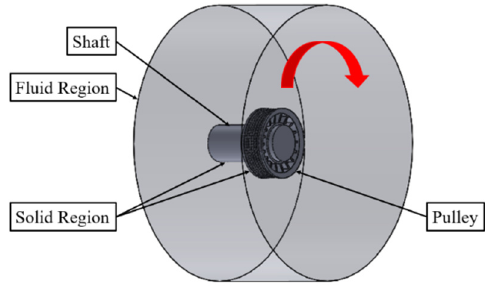
Figure 8. CAD model used for the simulation.